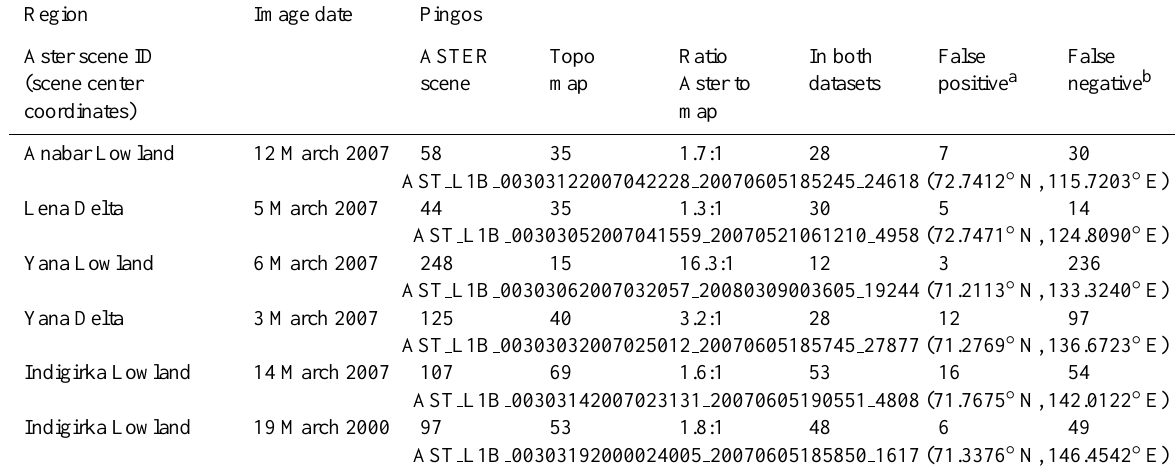
In both False False ASTER Topo Ratio datasets positive a negative b scene map Aster to map